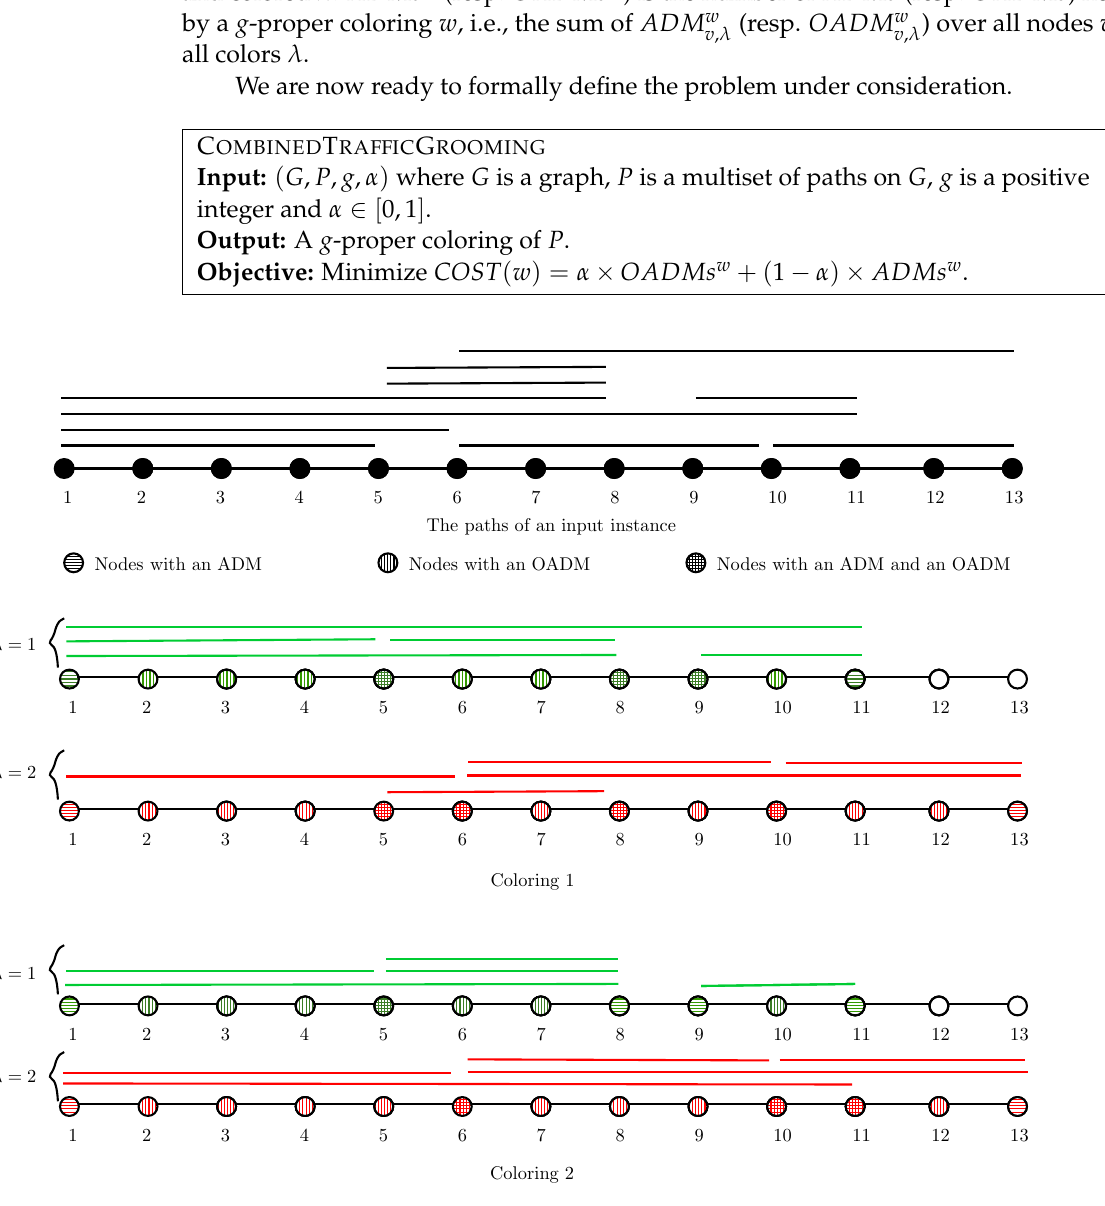
Figure 1. An input example on a chain network with 13 nodes and g = 3 at the top. Below are two possible colorings of the input paths. Both colorings use two colors. In the first coloring, the paths colored with λ = 1 use 5 ADMs (at nodes 1, 5, 8, 9 and 11) and 9 OADMs (at nodes 2, 3, 4, 5, 6, 7, 8, 9 and 10). The paths colored λ = 2 use 6 ADMs and 11 OADMs. This coloring uses 11 ADMs and 20 OADMs in total. On the other hand, the second coloring uses 10 ADMs and 18 OADMs in